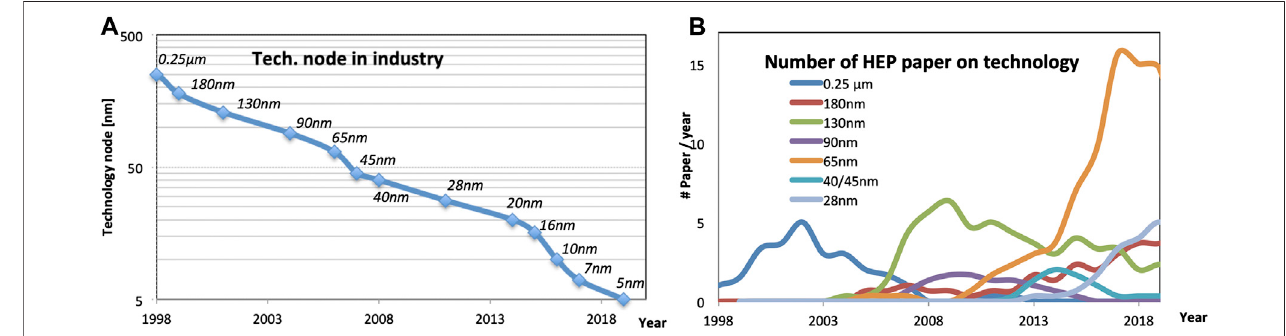
FIGURE 1 | (A) development of technology nodes in industry (example from one factory); (B) Number of HEP papers relevant to R&D of microelectronics design where a speci fi c CMOS technology is directly speci fi ed in the title: data shown are three years average and are obtained from a web based search